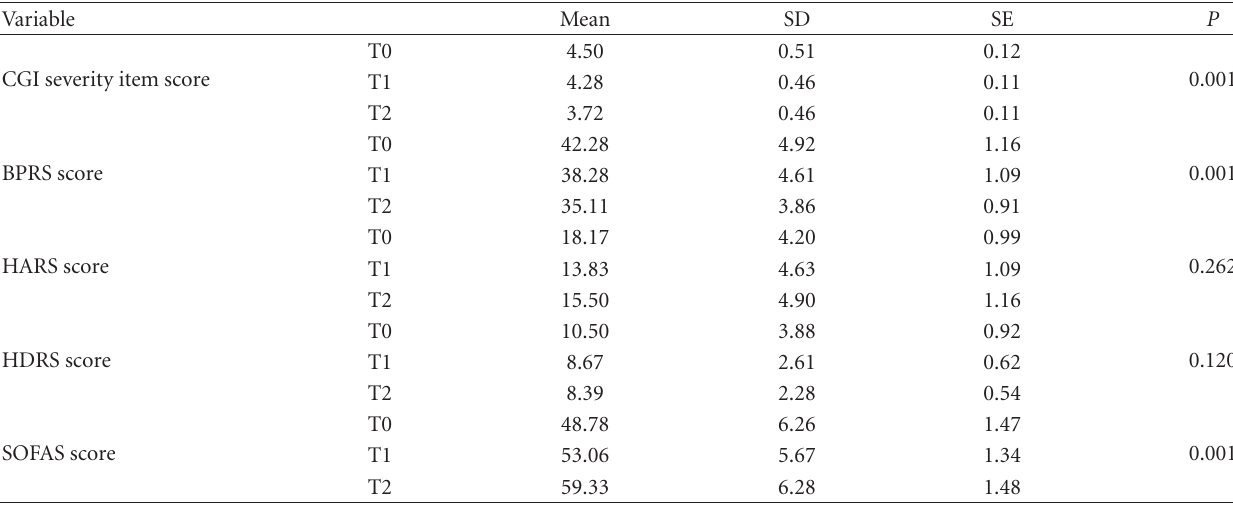
Table 1: Results of analysis of variance (ANOVA) for repeated measures with Bonferroni correction for multiple comparisons, performed with rating scales for BPD-related symptoms and social functioning in patients treated with paliperidone ER ( N = 14). Variable